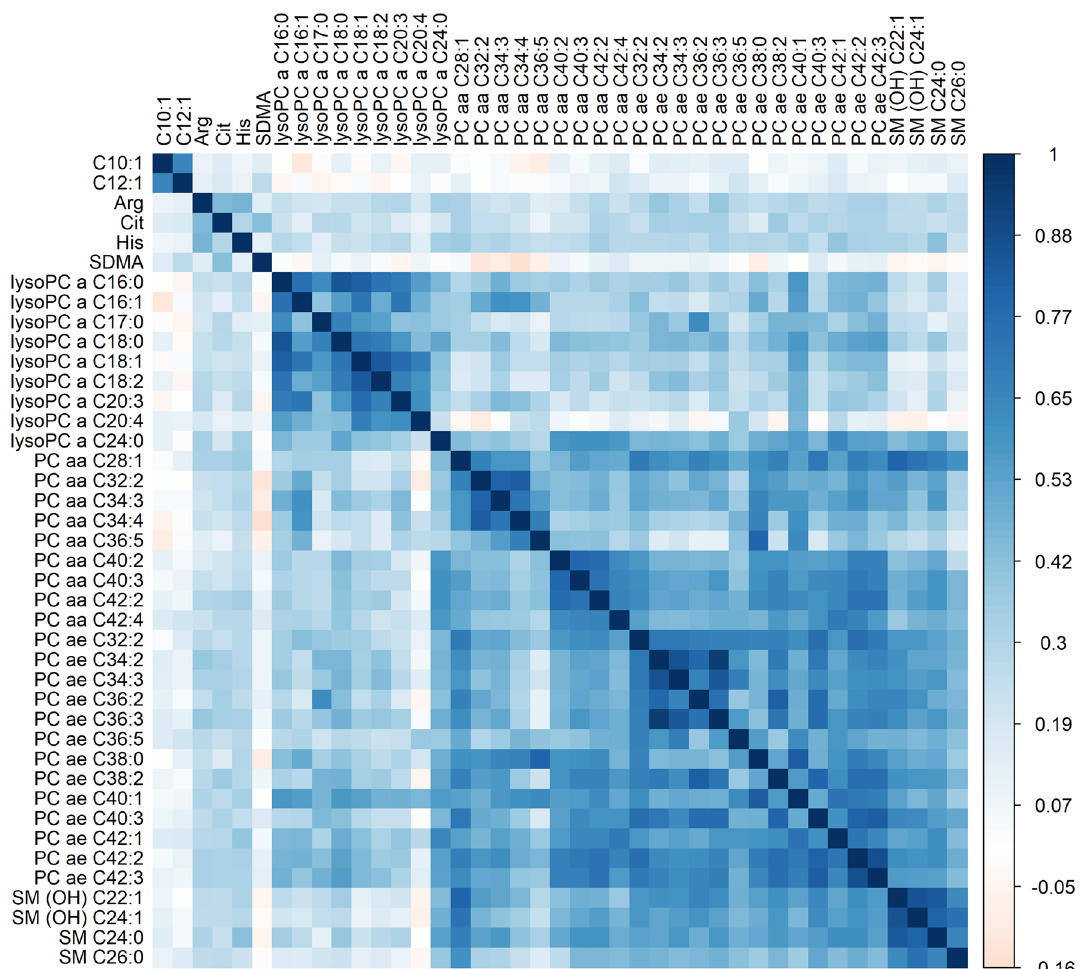
Figure 4. Heatmap of Spearman’s correlation coefficients at 6 weeks post-treatment between plasma concentrations of metabolites that were statistically significantly (FDR q-value < 0.05) related to self-reported time spent on moderate-to-vigorous physical activity (MVPA) and/or adherence to the physical activity guideline (≥ 150 min/week of MVPA) among colorectal cancer survivors. Similar patterns of correlations were observed at other post-treatment time points (results not shown). Heatmap of correlations among all analyzed metabolites at each time point is depicted in Supplementary Fig.